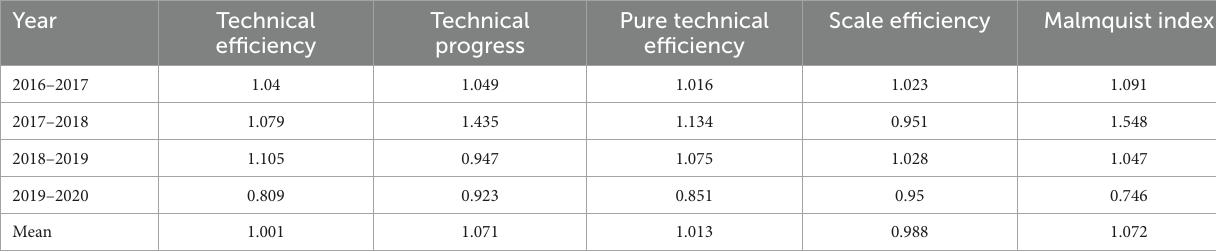
TABLE 4 Annual average Malmquist